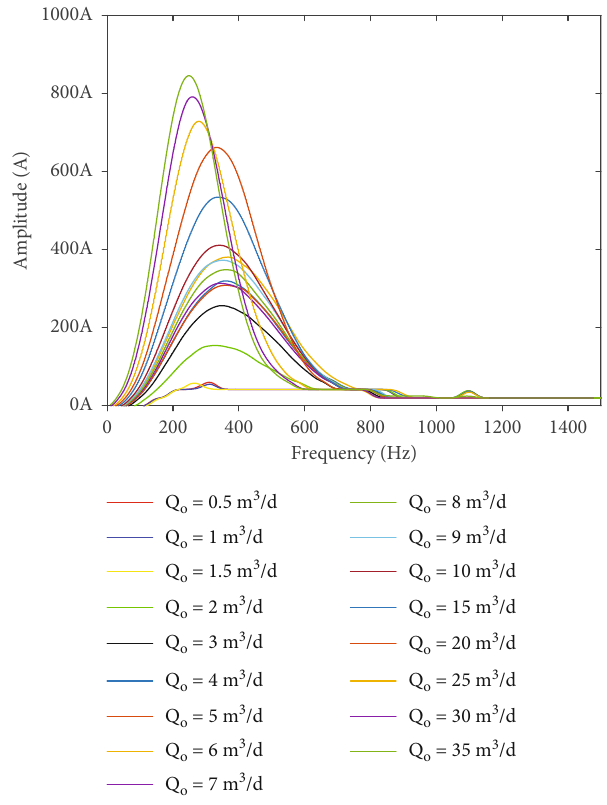
Figure 4: Hydrostatic oil injection power spectrum